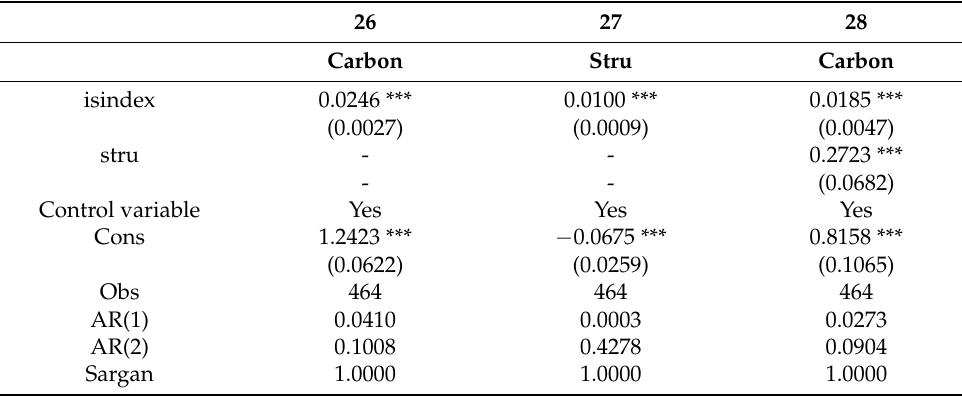
Table 7. Intermediary effect of industrial structure.